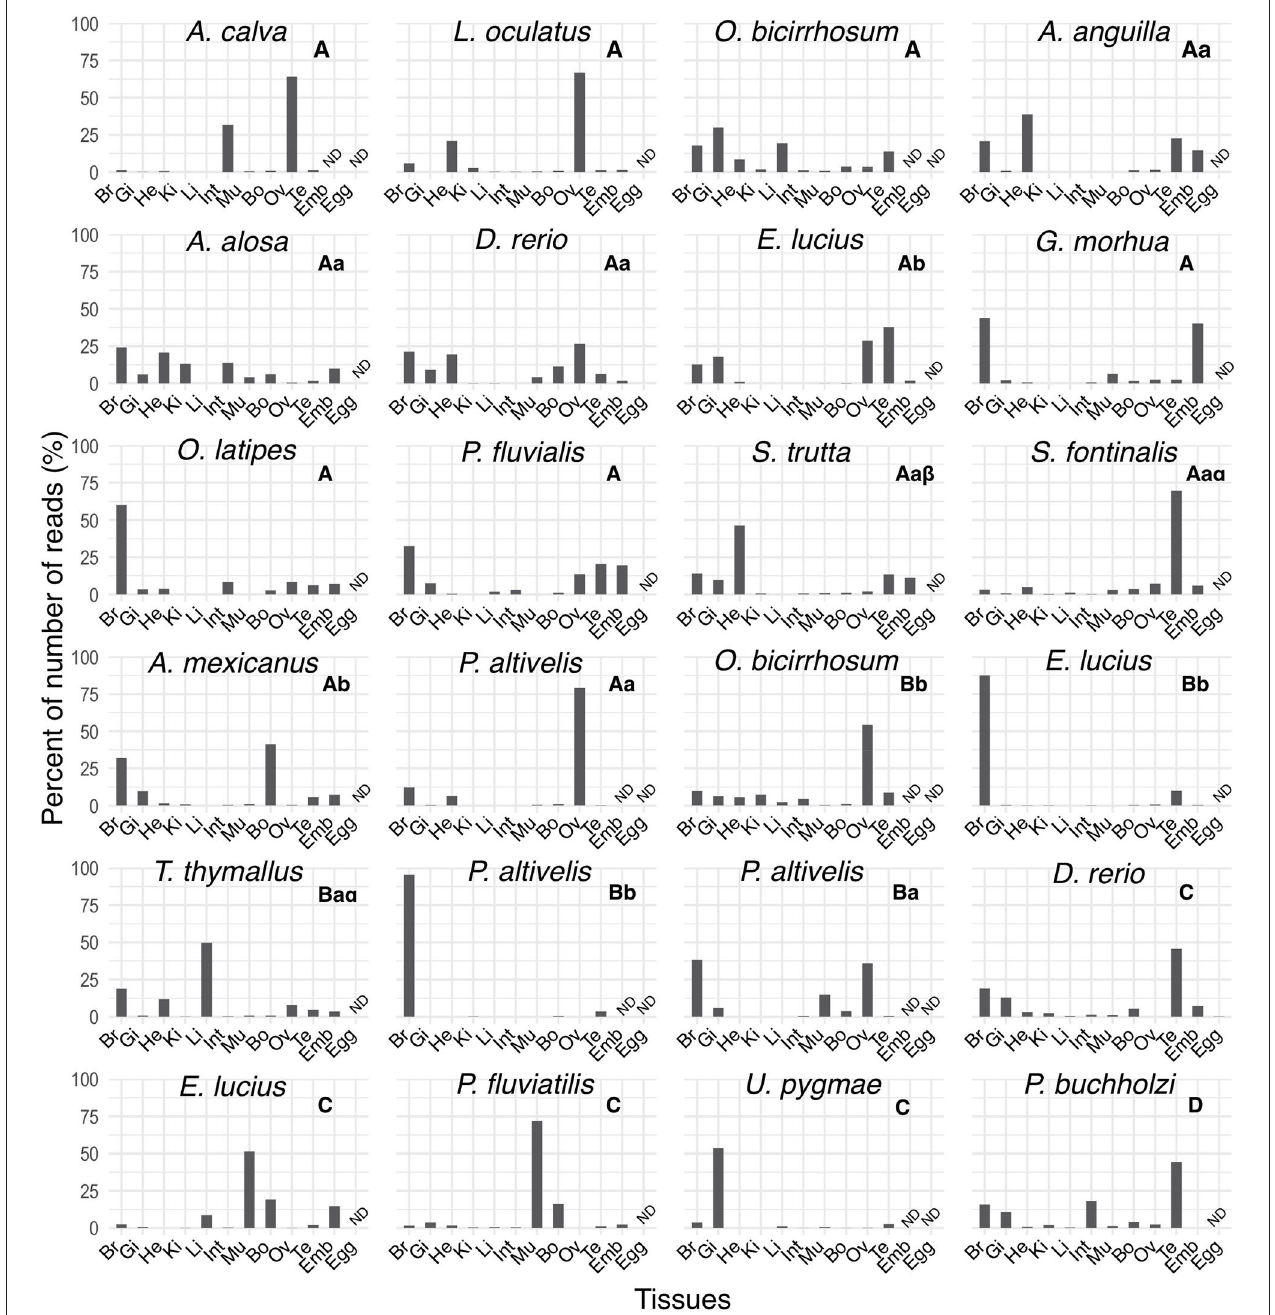
FIGURE 8 | Tissue distribution profiles of melatonin receptors in different ray-finned fish in the PhyloFish database. The bar plots represent the relative expression calculated as the percentage of the maximum rpkm (number of reads per kilo base per million reads) value per species. The mtnr transcripts were found by exploring the PhyloFish database (17) and transcript identity was established by phylogenetic analysis (data not shown). Subtype identity is given at the top of each graph. ND indicates a tissue for which data were not available.